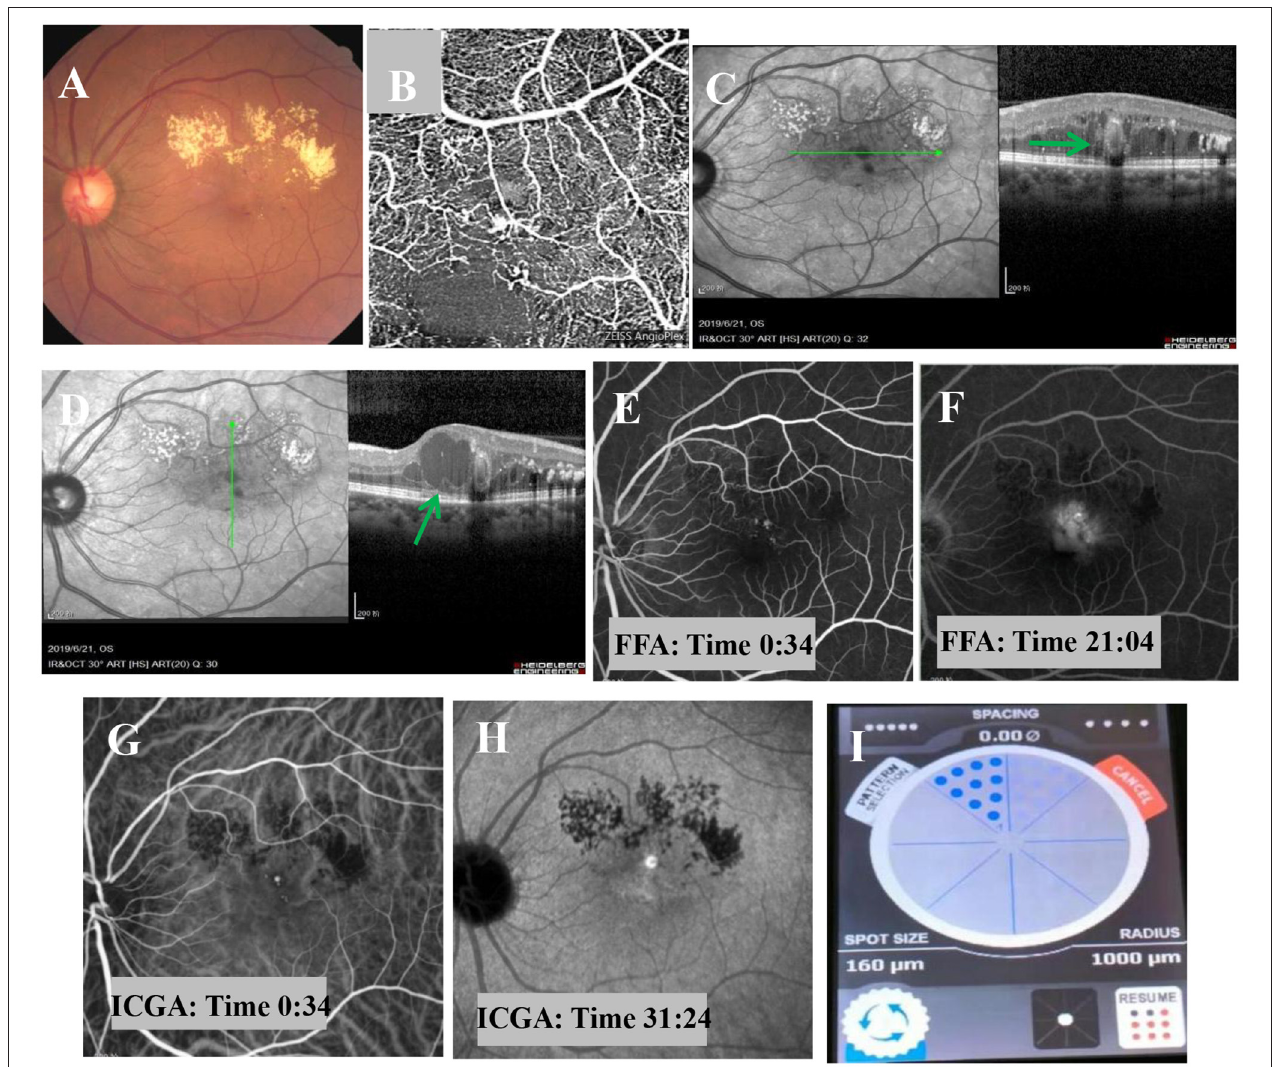
FIGURE 2 | Fundus examination one month after intravitreal injection of anti-VEGF. (A) Fundus examination shows muddy-like exudation above the macular area, punctate hemorrhage, and no obvious change in the off-white lesions adjacent to the macula. (B) OCT-A shows sparse blood vessels, dilated superficial blood vessels, and a tangled nodule beside the blood vessels. (C,D) OCT imaging shows macular edema, dot-like hyperreflexia between layers, light on the outside and black on the inside, with no obvious change in oval structure (bold green arrow), and cystic edema in some parts of the macular area (bold green arrow). (E,F) FFA shows a strong fluorescent focus with a clear boundary near the macula in the early stage and obvious leakage in the later stage. (G,H) ICGA shows well-defined, strong fluorescence near the macula in the early stage, but no obvious leakage in the later stage. (I) The MPL treatment was delivered in a fan shape, covering the focus and the upper edema